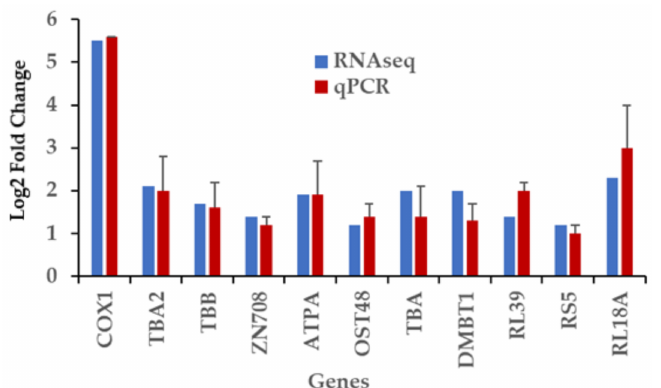
Figure 7. Reverse-transcription real-time PCR validation of eleven genes differentially modu- lated by captivity. COX1, cytochrome c oxidase subunit 1; TBA2, tubulin α chain 2; TBB, Tubu- lin β chain; ZN709, zinc finger protein 709; ATPA, ATP synthase subunit α ; OST48, dolichyl- diphosphooligosaccharide-protein glycosyltransferase non-catalytic subunit; TBA, tubulin alpha chain; DMBT1, deleted in malignant brain tumors 1; RL39, ribosomal protein L39; RS5, ribosomal protein S5; RL18A, ribosomal protein L18a. Data is expressed as relative expression compared to that of wild sea cucumbers ( n =